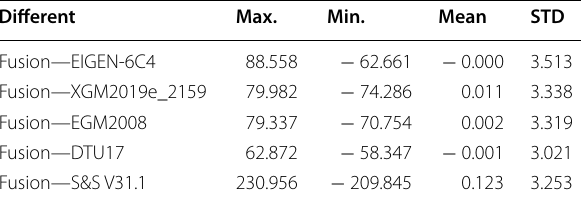
Table 6 Accuracy evaluation results of GMGA1 (unit: mGal)